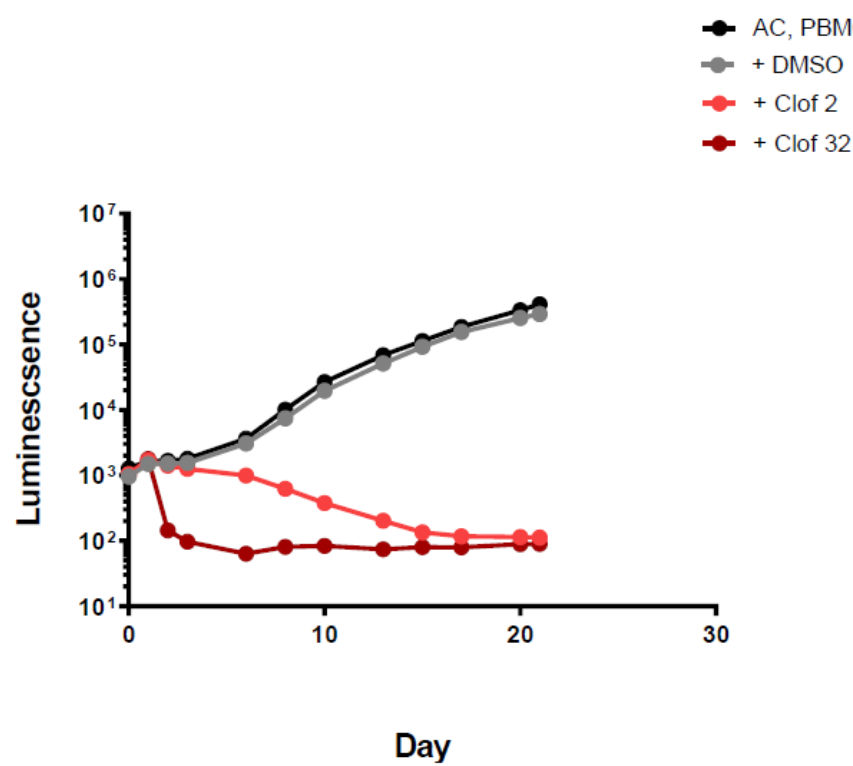
Figure 1. Luminescence detection at different time points for clofazimine in TB-infected PMBCs obtained from donor 1. AC: alginate collagen; PMBCs: peripheral blood mononuclear cells; Mtb: Mycobacterium tuberculosis; DMSO: dimethyl sulfoxide; Clof 2: Clofazimine 2 mg/L; Clof 32: Clofazimine 32 mg/L.